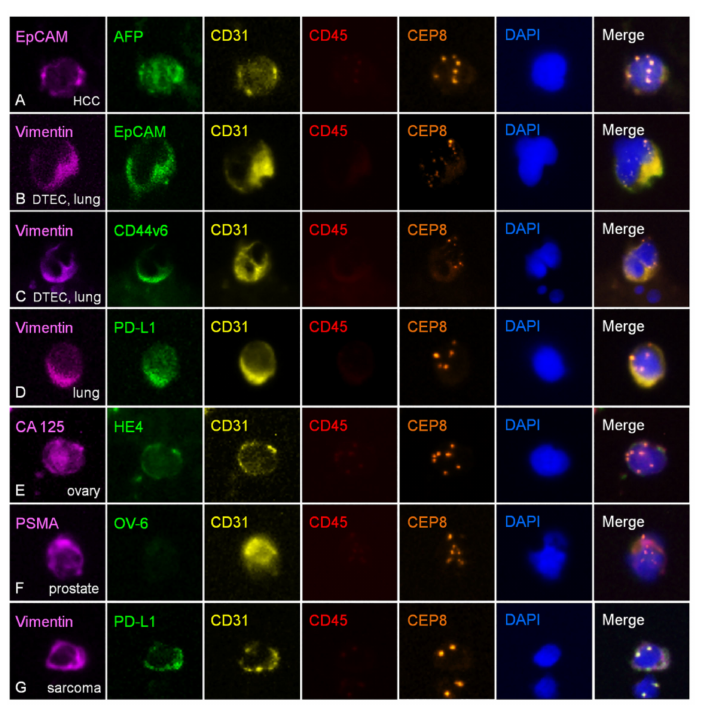
Figure 2. In situ phenotypic and karyotypic characterization of aneuploid CTECs and disseminated tumor-derived ECs (DTECs) detected in varieties of cancer patients by the integrated immunostaining-fluorescence in situ hybridization (iFISH). Aneuploid TECs in peripheral blood (CTECs) and bone marrow (BM; DTECs) of a variety of carcinoma patients were enriched by subtraction enrichment (SE), followed by 6-channel iFISH to simultaneously co-characterize aneuploidy of chromosome 8 and TM expression in CD31 + / CD45 – CTECs and DTECs. ( A ) An aneuploid hepatocellular carcinoma (HCC) CTEC enriched from blood had plasma membrane staining of the stemness marker EpCAM and cytoplasmic vesicular staining of secretory α -fetoprotein (AFP). ( B ) A multinuclear mesenchymal (Vimentin + ) and EpCAM + DTEC fusion cluster enriched from bone marrow in a non-small cell lung cancer (NSCLC) patient (DTEC microemboli). The cell cluster in BM had dual phenotypes of both epithelium and mesenchyme. ( C ) A multinuclear mesenchymal (Vimentin + ) and stemness marker CD44v6 + DTEC fusogenic microembolus in BM of a lung cancer patient. The cell cluster in BM was composed of disseminated tumor-derived endothelial stem cells (DTESCs) with a mesenchymal phenotype. ( D ) An aneuploid mesenchymal (Vimentin + ) NSCLC CTEC revealed a granule-like staining of PD-L1, suggesting that PD-L1 may localize in the secretory granules. ( E ) An aneuploid ovarian cancer CTEC showed a positive staining of cytoplasmic vesicle-like CA 125 and human epididymis protein 4 (HE4). ( F ) An aneuploid prostate cancer CTEC had a positive plasma membrane and cytoplasmic staining of the prostate-specific membrane antigen (PSMA), but negative for the oval cell marker OV-6 staining. ( G ) A diploid mesenchymal (Vimentin + ) and PD-L1 + sarcoma CTEC. Fluorescence dyes conjugated to diverse antibodies (Cytelligen, USA): Alexa Fluor 488 (green), AF594 (red), Cyanine 5 (yellow), and Cy7